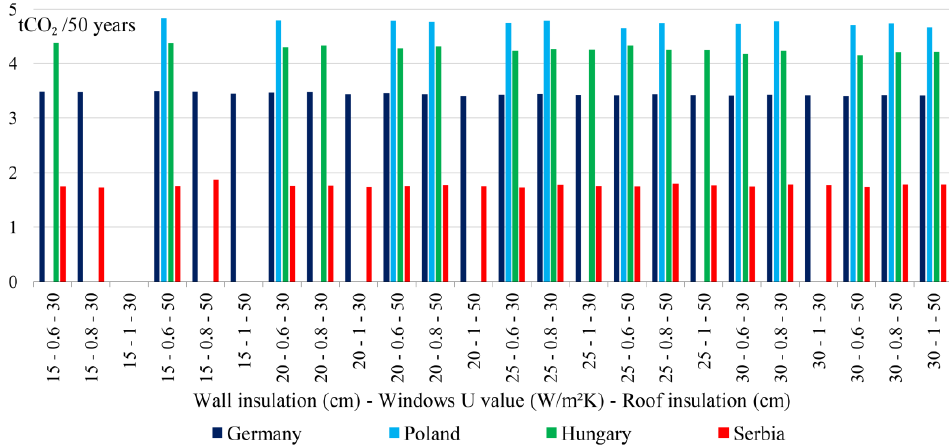
Figure 9. tCO 2 saved per PH compliant buildings ’ lifetime (50 years) per 1000 € invested .